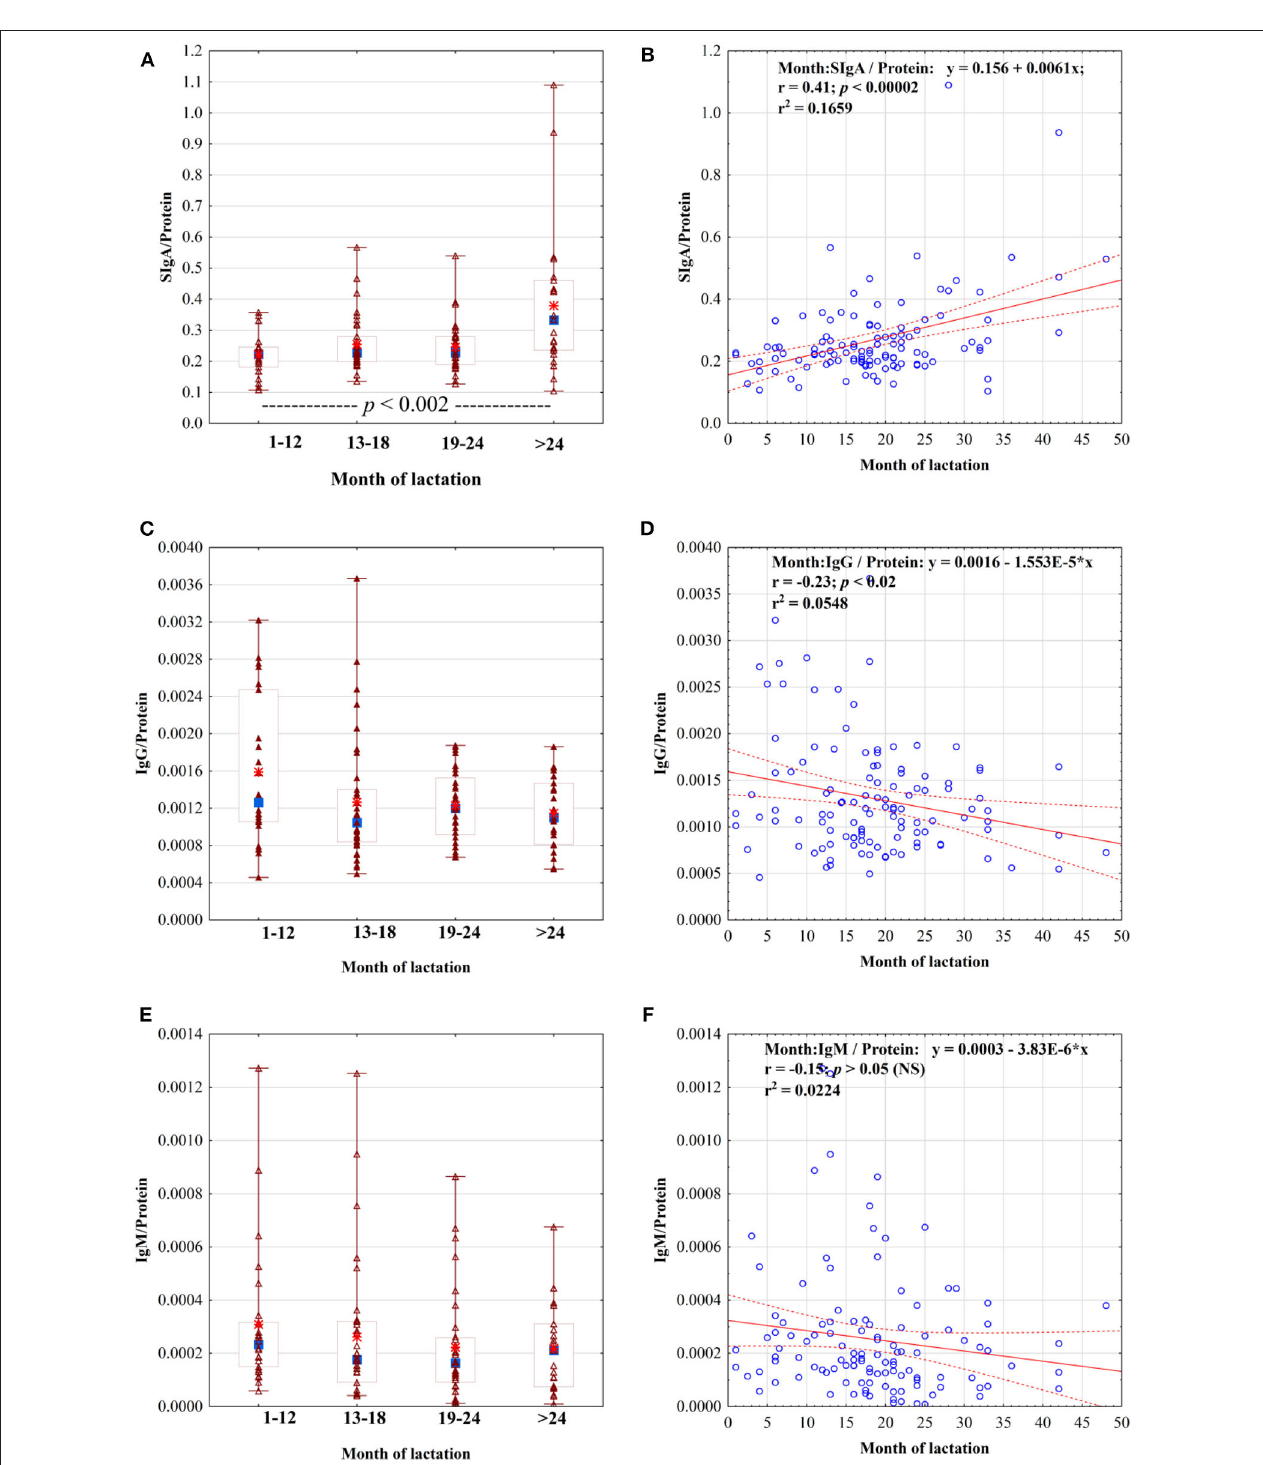
FIGURE 2 | The ratio of skim milk SIgA (A) , IgG (C) , and IgM (E) to the protein concentration in the four groups analyzed: group 1, up to 12 months ( N = 26); group 2, from 13 to 18 months ( N = 35); group 3, from 19 to 24 months ( N = 32); and group 4, over 24 months ( N = 23), and correlation of Igs/protein ratio with 48 months of lactation: (B) SIgA/protein, (D) IgG/protein, and (F) IgM/protein. For (B,D,F) , a solid line indicates linear regression, and 95% confidence intervals are shown by dotted lines; blue circles refer to individual samples. For (A,C,E) , symbols: median ( (cid:4) ), 25–75% ( (cid:3) ), min–max (I), sample ( (cid:3) ), and mean (*).